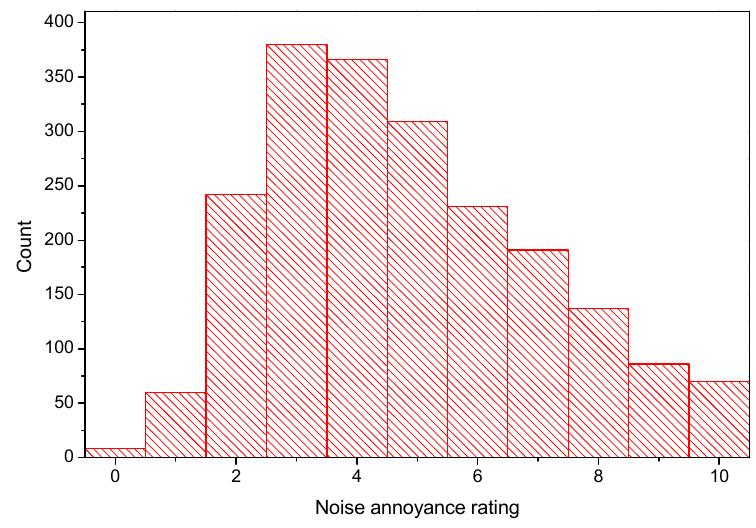
Figure 3. Statistics of subjective annoyance rating samples.